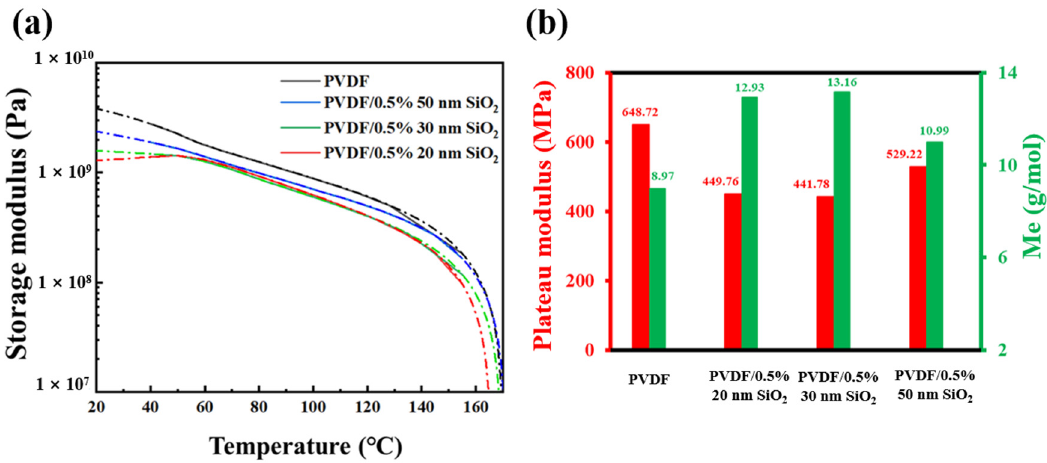
Figure 5. ( a ) The storage modulus of PVDF and PVDF/SiO 2 nanocomposites varies with temperature at 1 Hz. ( b ) Plateau modulus of PVDF and PVDF/ SiO 2 nanocomposites. at 1 Hz. ( b ) Plateau modulus of PVDF and PVDF/ SiO